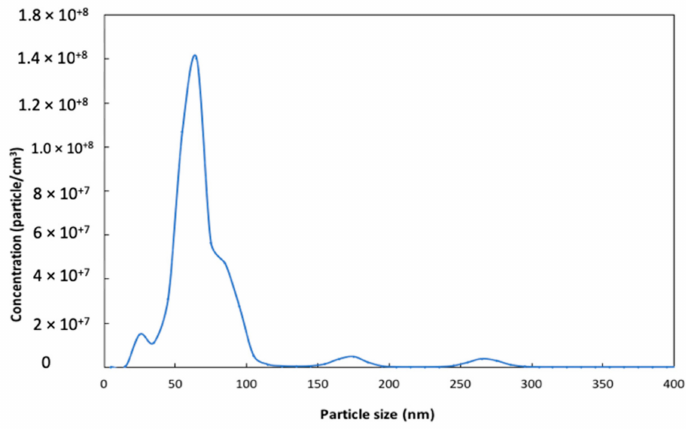
Figure 4. Results of particle size test for